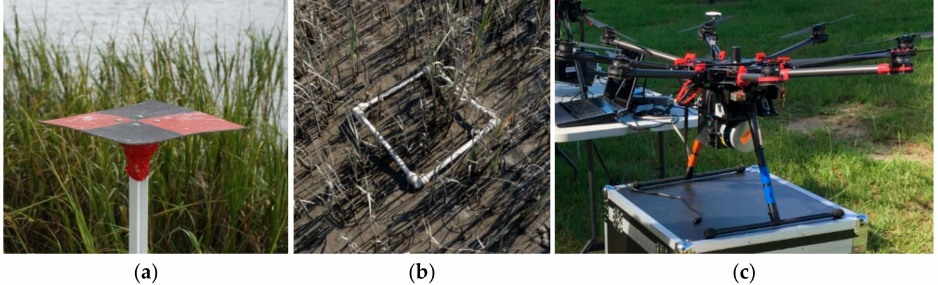
Figure 2. ( a ) A ground control point (GCP). ( b ) The plot we used for the field survey. ( c ) The UAV (DJI Matrice 600) we used to collect the LiDAR point